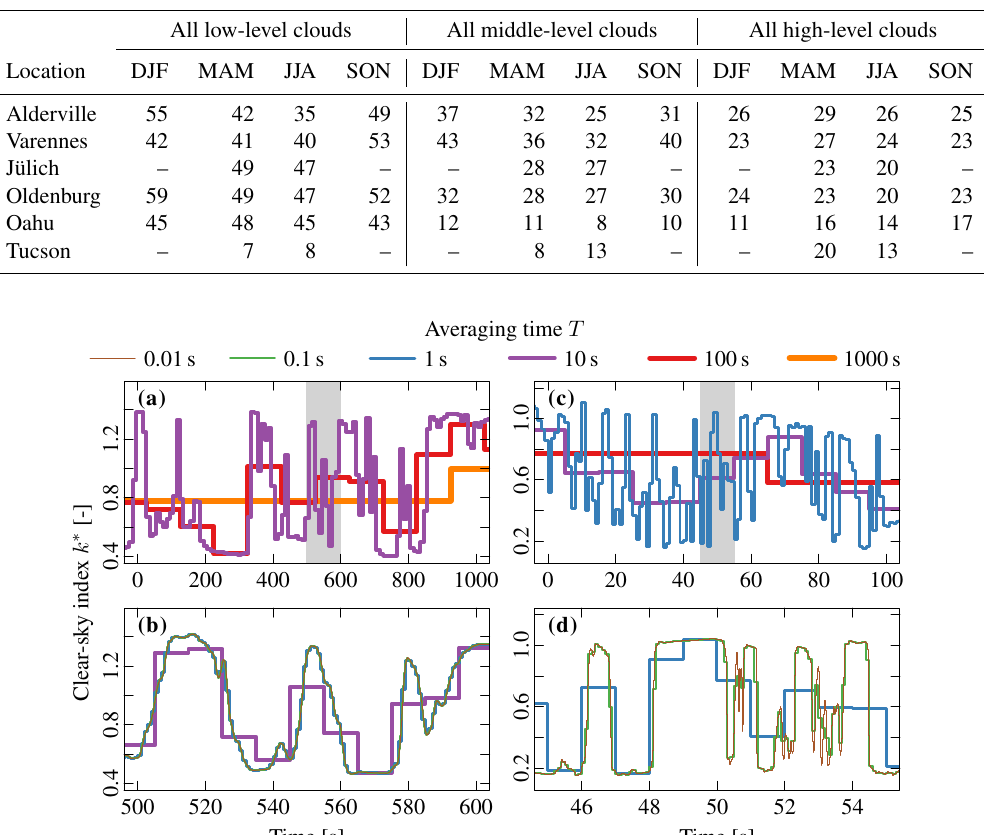
Table 3. Average cloud amount [%] during the day for each season (winter: DJF, spring: MAM, summer: JJA, autumn: SON) extracted from the Climatic Atlas of Clouds Over Land and Ocean (Eastman et al., 2014) for all six locations in question. Values are grouped by cloud altitude, with the low-level including fog, stratus (St), stratocumulus (Sc), cumulus (Cu), and cumulonimbus (Cb); the middle-level consisting of nimbostratus (Ns), altostratus (As), and altocumulus (Ac); and the high-level representing all cirriform clouds combined (Hahn and Warren, 2007). For the short-term measurement campaigns near Jülich and Tucson, only those data corresponding to the study periods are quoted. Note that Jülich and Oldenburg are located within the same grid box of the cloud atlas and hence feature identical values.